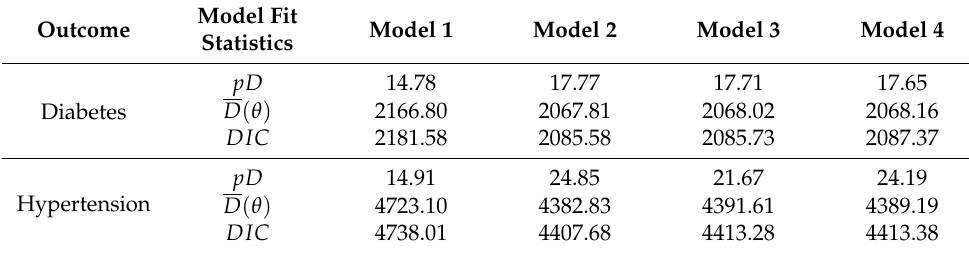
Table 2. Bayesian values of stationary model diagnostic measures.